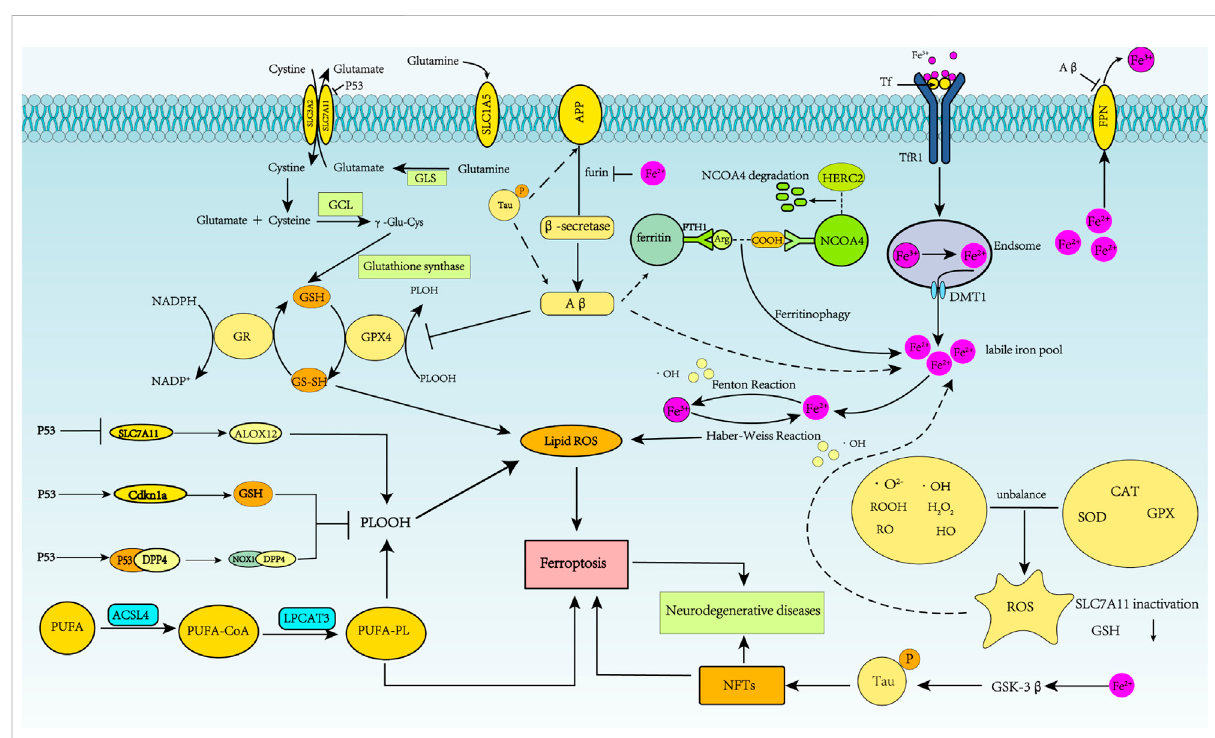
Schematic representation of ferroptosis regulation of Alzheimer ’ s disease. In AD, APP is fi rst cleaved by β -secretase, and neurotoxic A β is produced. Abnormal phosphorylation of the tau protein can lead to increased APP and A β 40 aggregation. Fe 2+ enhances β -secretase activity by reducing furin protein expression, thereby increasing A β production through the amyloidosis pathway. A β 1-42 directly induces down-regulation of FPN. Increased intracellular liberation of Fe 2+ activates the ferroptosis pathway. A β can decrease levels of GPX4 and elevate levels of ferritin. Excessive iron in neurons can lead to tau hyperphosphorylation and NFT formation through the GSK-3 β kinase